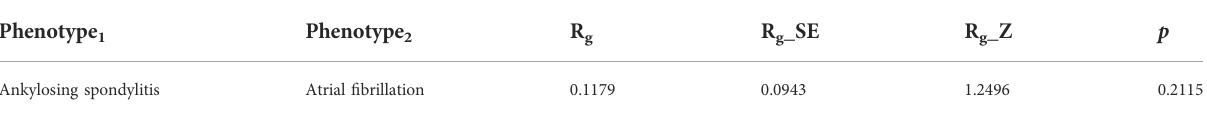
TABLE 4 The genetic correlation results of LDSC